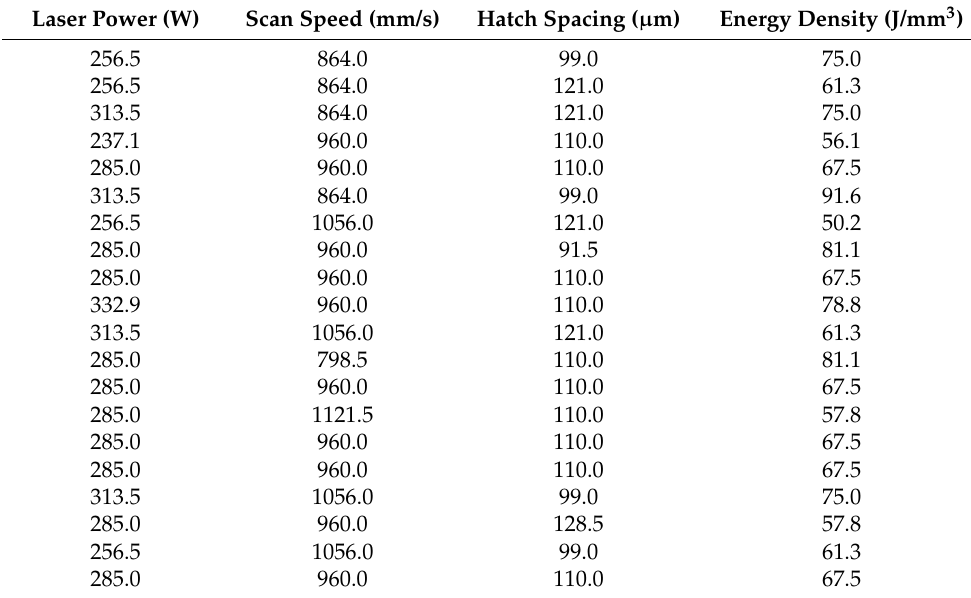
Table 1. Values of the process parameters used in this study. Laser Power